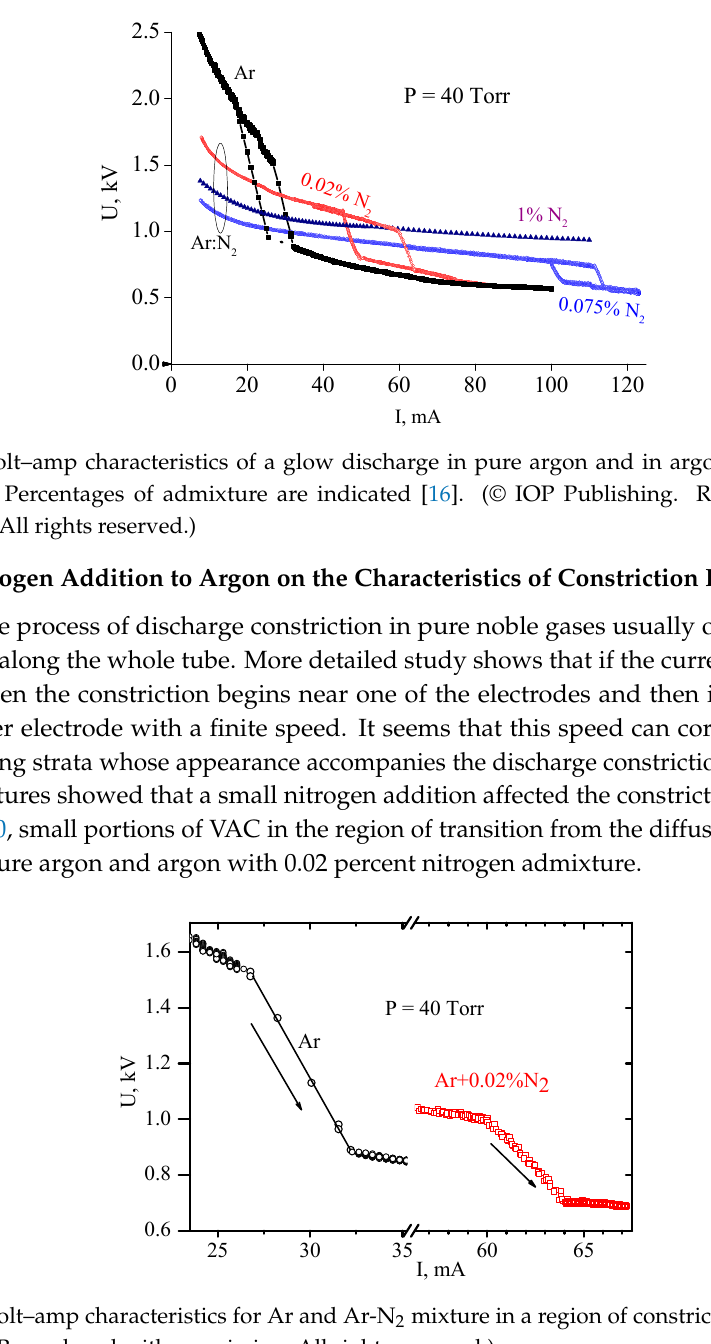
Figure 10. Volt–amp characteristics for Ar and Ar-N 2 mixture in a region of constricting [16]. (© IOP Publishing. Reproduced with permission. All rights reserved.)